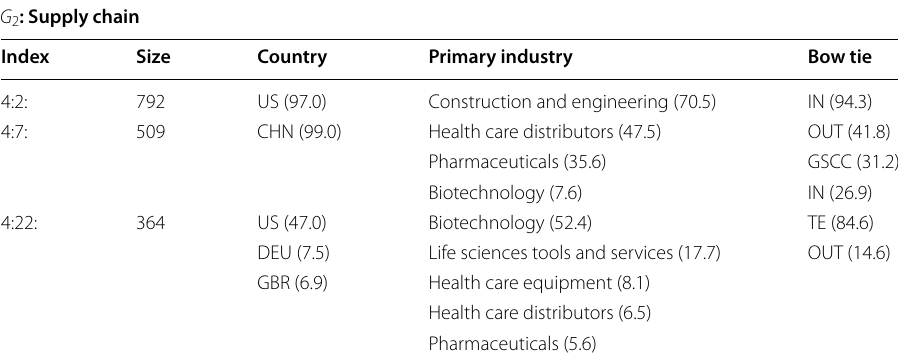
Table 10 Characteristics of the three largest communities in the fourth community at the second level for the supply chain